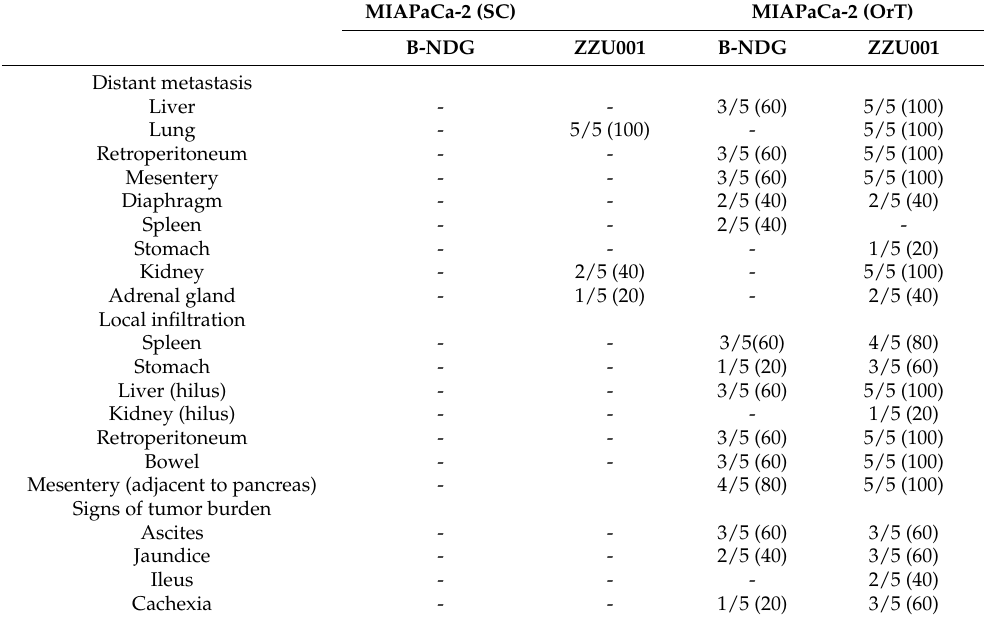
Table 1. (From [38], with permission). Metastasized organs and metastasis frequency by MIA-PaCa-2 cells transplanted subcutaneously (SC) and orthotopically (OrT) in hamsters and